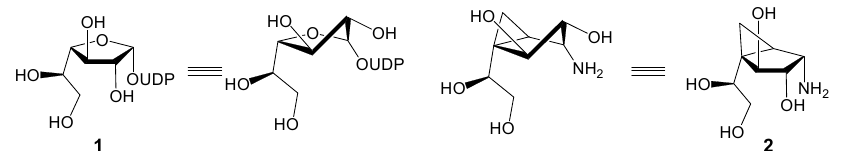
Scheme 1. The β -Gal f -(1 → 6)- β -Gal f transferase activity of mycobacterial galactofuranosyltransferase GlfT2. Gal f : galactofuranose.